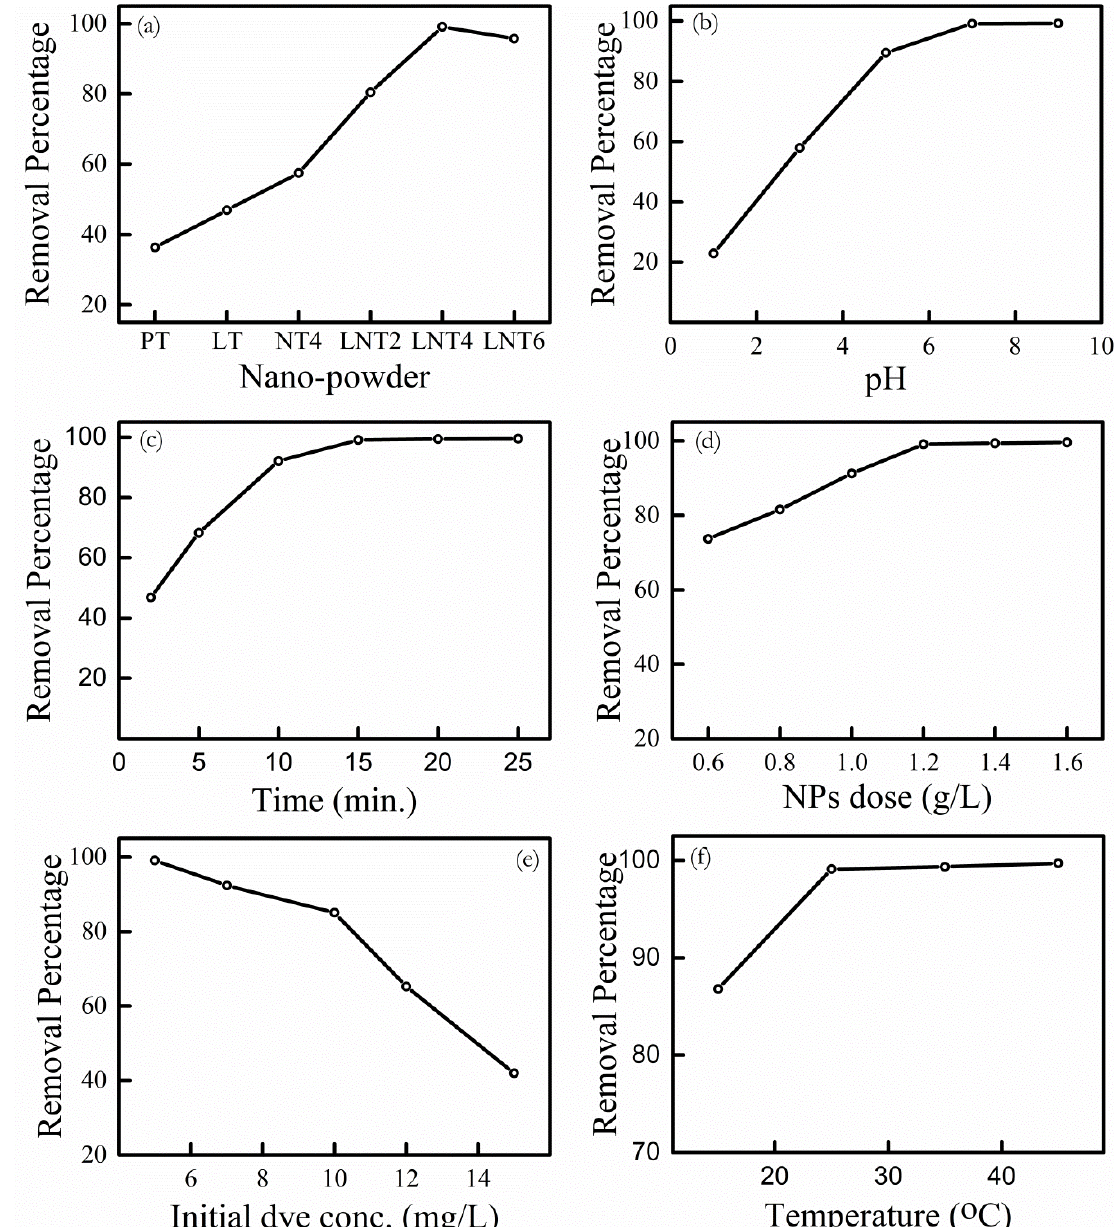
Figure 5. ( A ) Effect of doping in TiO 2 on dispersion zeta potential at different potential. ( B ) The dispersion isoelectronic point (IEP) for different